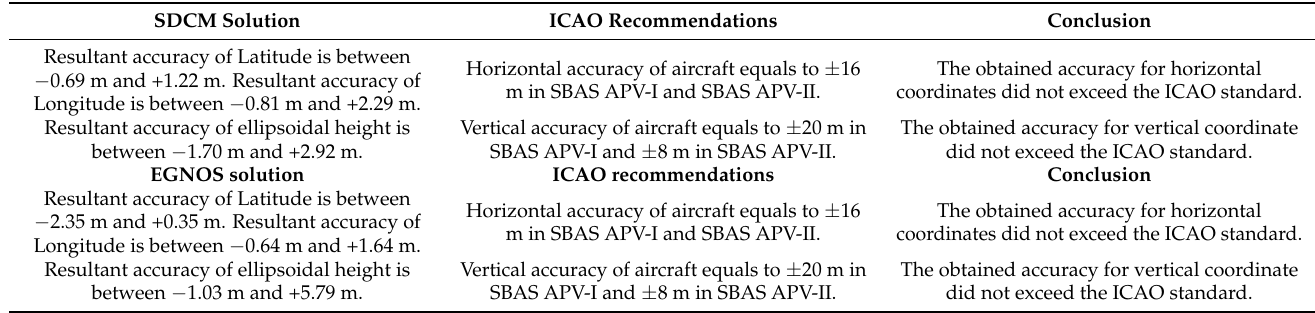
Table 2. Comparison of resultant accuracy results from SDCM and EGNOS solutions with reference to ICAO technical standards